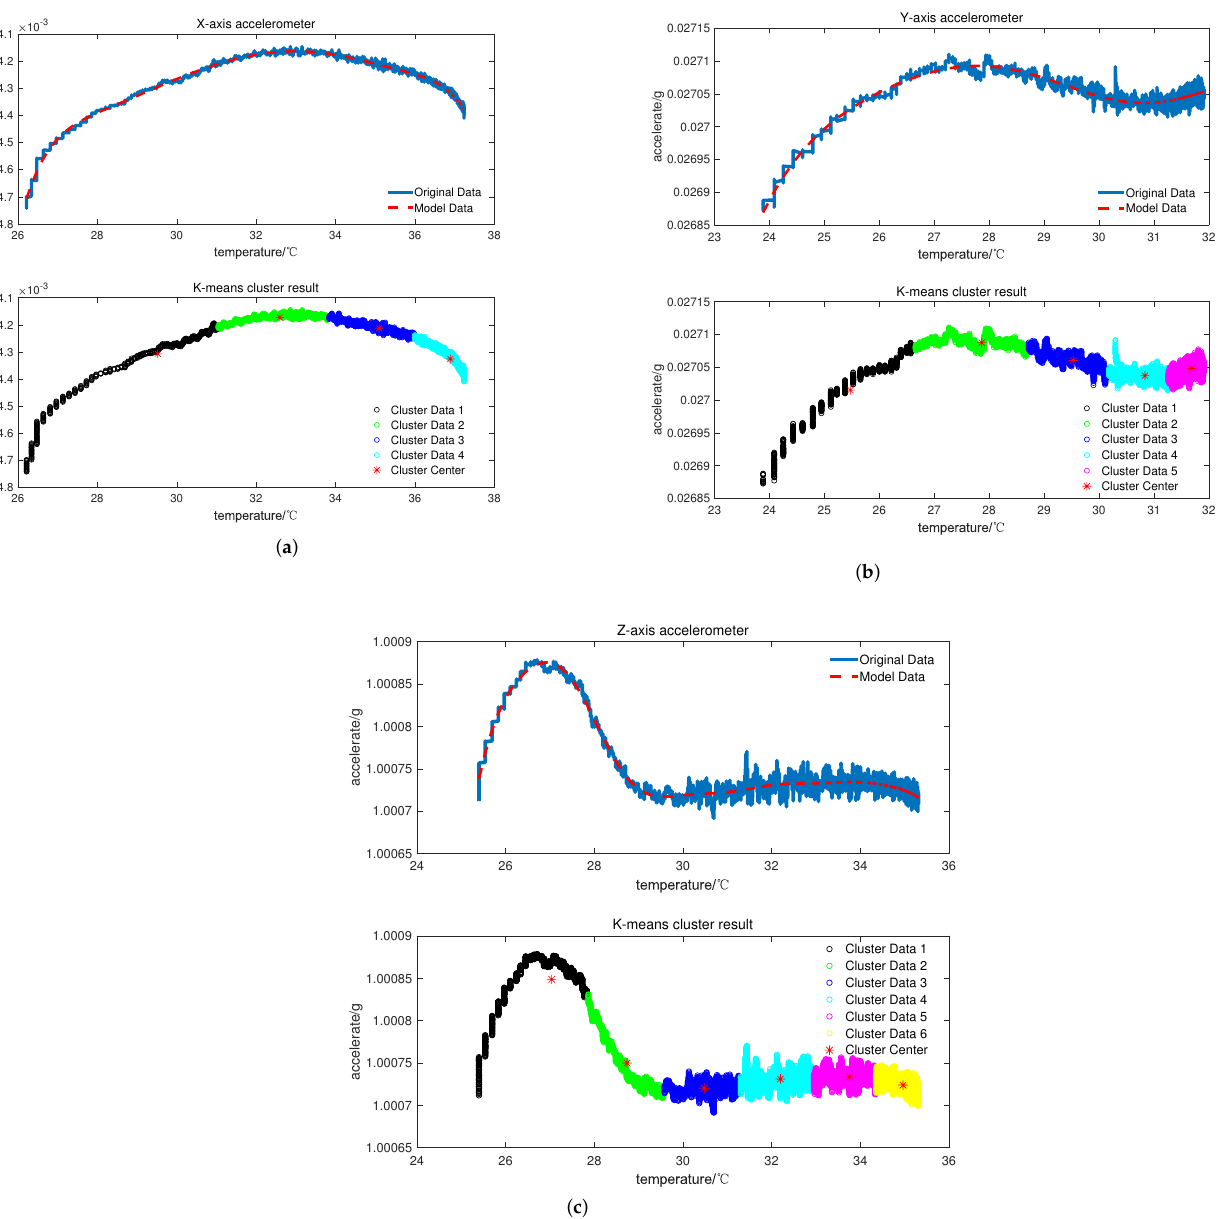
Figure 6. Identification diagram of the model for the three-axial accelerometer: ( a ) X -axis accelerome- ter; ( b ) Y -axis accelerometer; ( c ) Z -axis